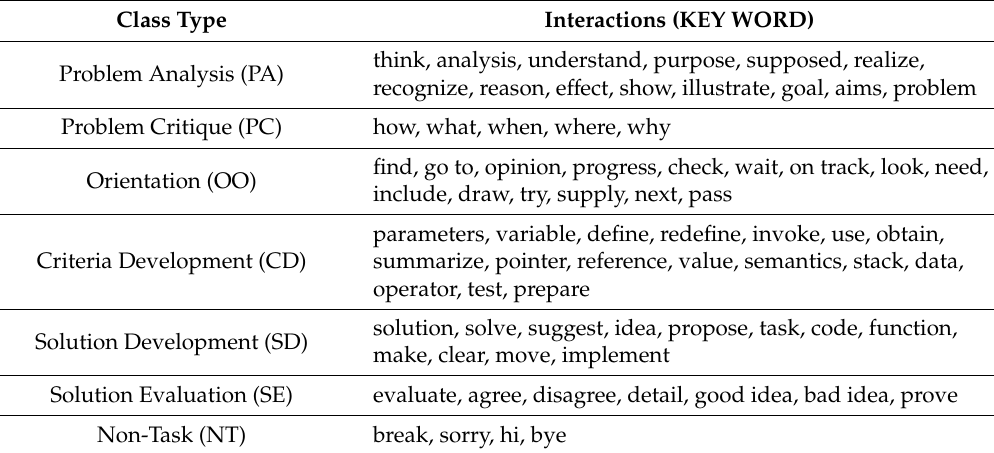
Table A1. FCS class interaction used in case